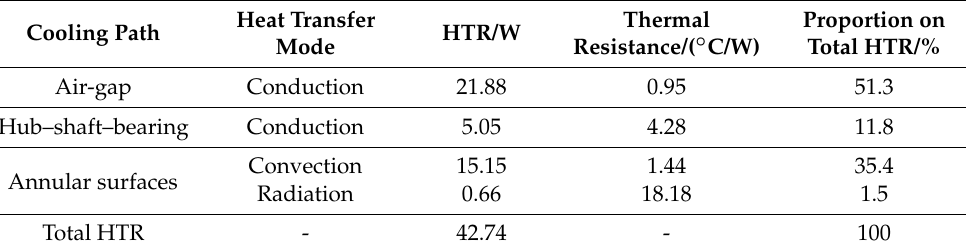
Table 5. Heat transfer rate (HTR) distribution of each cooling